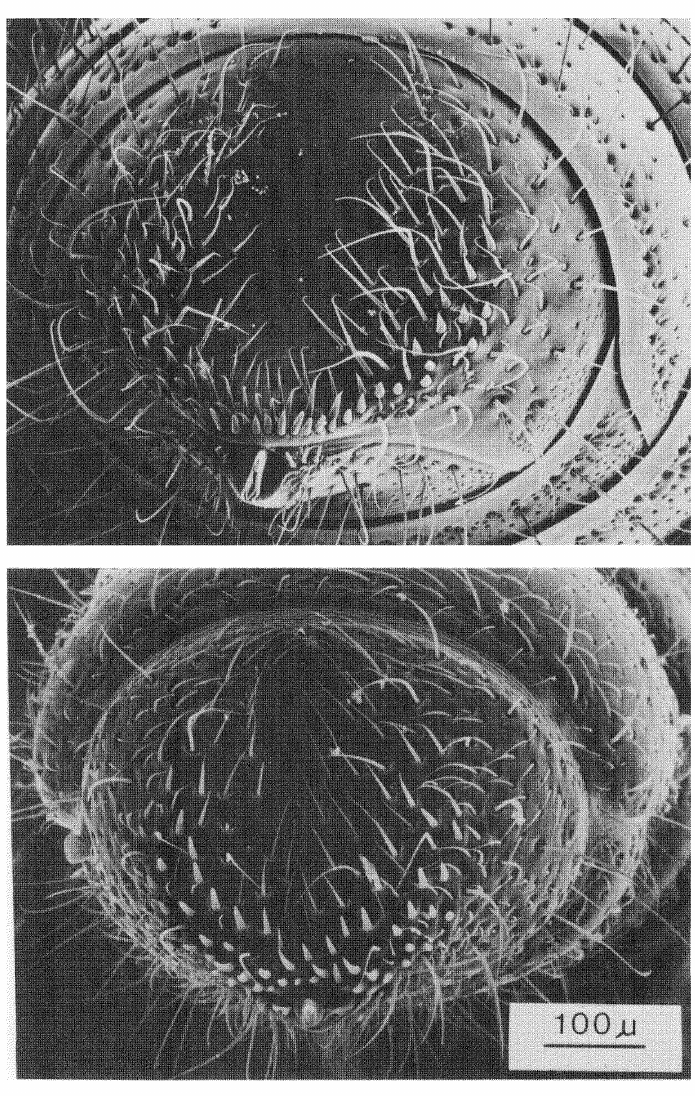
Figure 6. SEM picture of frontal view of pygidium of a Cerapach.vs worker (a), and a worker of Sphinctom.vrmex steinheili (b). Note the arrangement of the two kinds of setae on the truncated pygidial plate of both